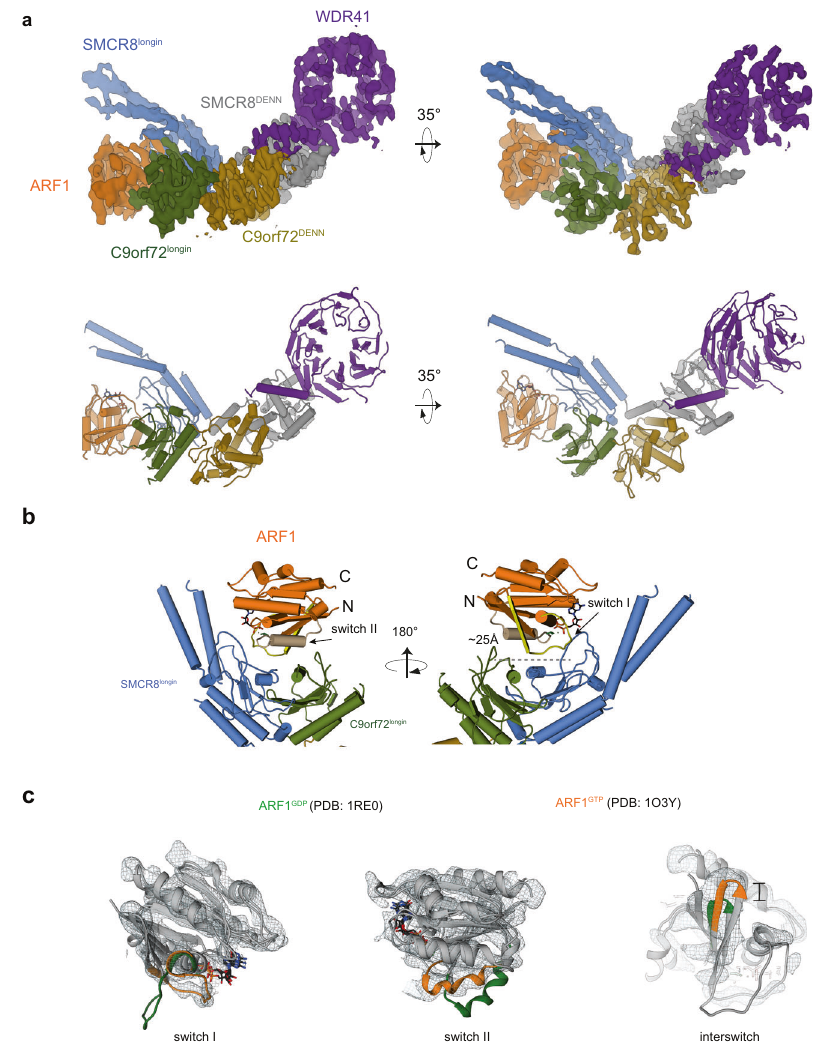
Fig. 2 Cryo-EM structure of C9orf72:ARF1-SMCR8:WDR41 complex. a Cryo-EM densities and the re fi ned atomic model of the complex. The domain colored as followed: SMCR8 longin , corn fl ower blue; SMCR8 DENN , gray; C9orf72 longin , olive; C9orf72 DENN , goldenrod; WDR41, medium purple; ARF1: orange. b ARF1 sits on the top of the two longin domains. The switch I and II of ARF1 are colored in yellow and tan, respectively. c Structural comparison of ARF1 in GTP versus GDP-bound states (from the left to right panels, switch I and II and interswitch). ARF1 in GTP state fi ts into the